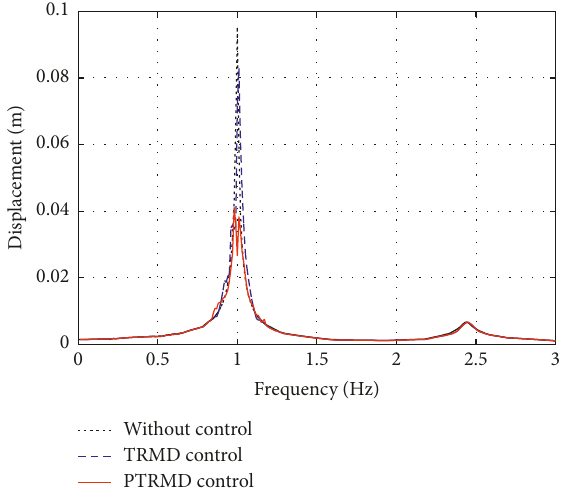
Figure 14: Displacement response of the structure under sinu- soidal excitation.